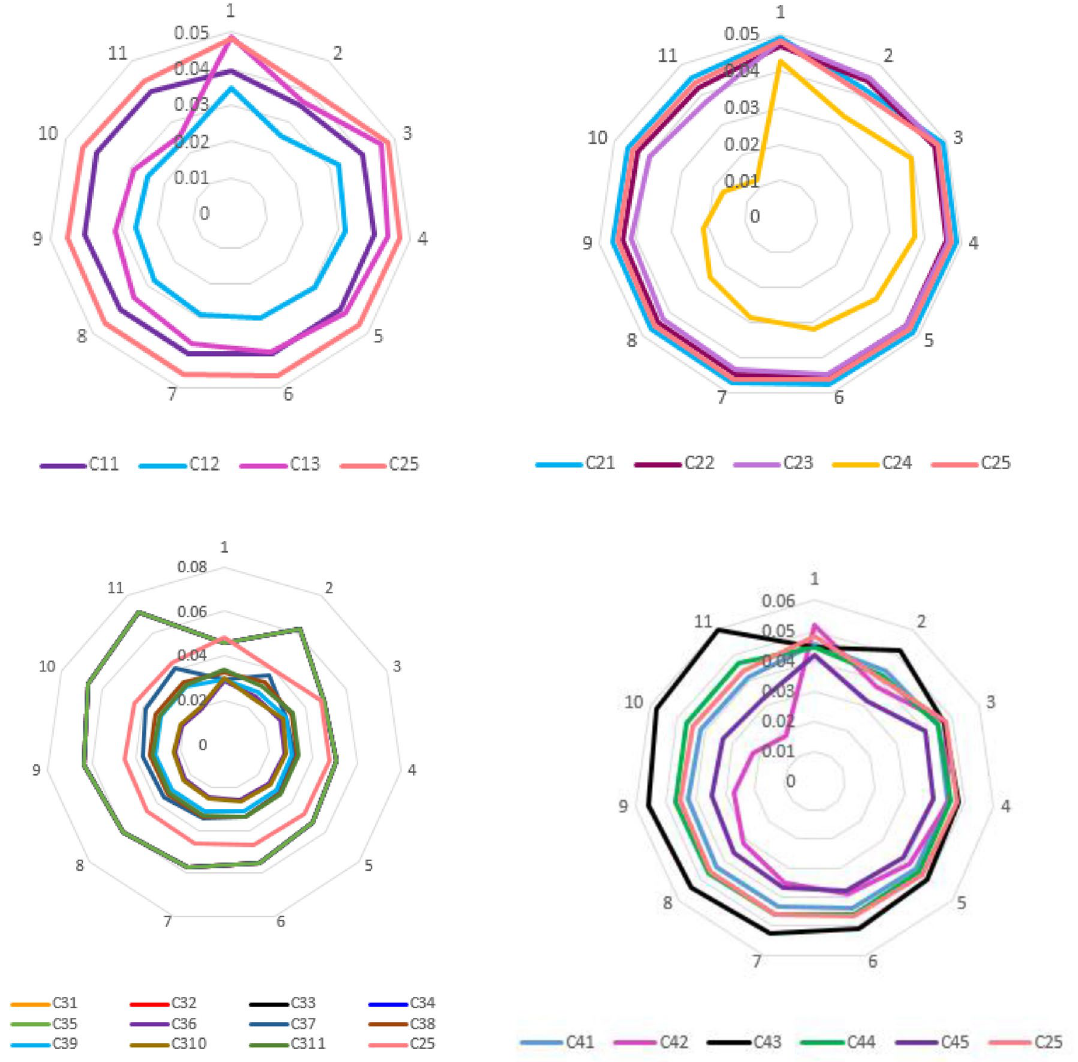
Figure 7. The status of each subjective weight relative to the reference criterion